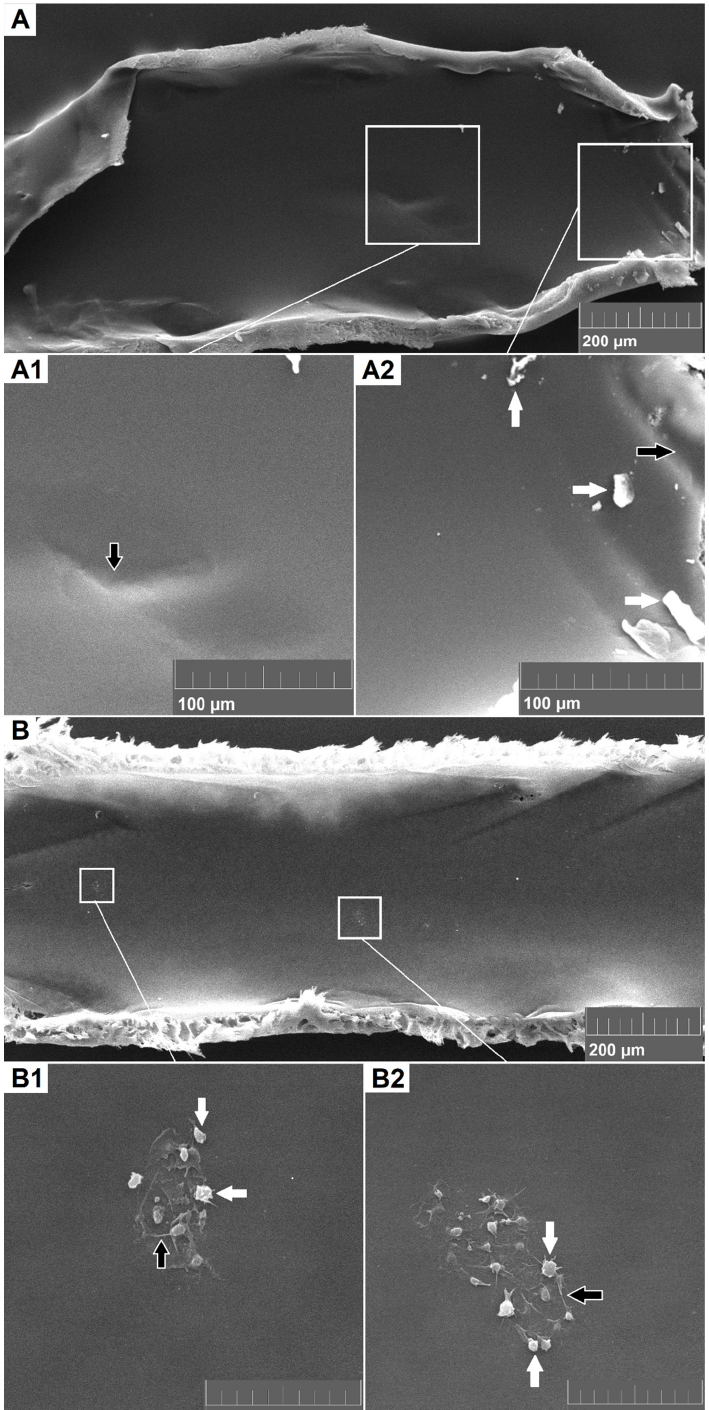
Figure 3. Scanning electron microscopy of the inner surface of dialyzer fibers with magnified details. ( A ) Dialyzer’s inner surface clear of biologic depositions (SEM clotting score of 0), with signs of mechanical damage, most likely caused by tweezers during fiber manipulation (black arrow in ( A1 , A2 ), and inorganic particles (i.e., debris of fiber wall), most likely produced during cutting (white arrow in ( A2 )). ( B ) Minimal depositions of platelets (white arrows in ( B1 , B2 )) and fibrin ((black arrows in ( B1 , B2 )) SEM clotting score of